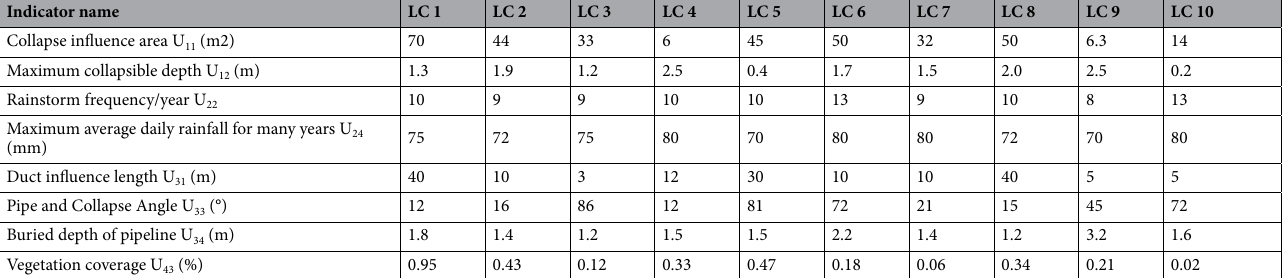
Table 4. Initial data of eight quantitative indexes.